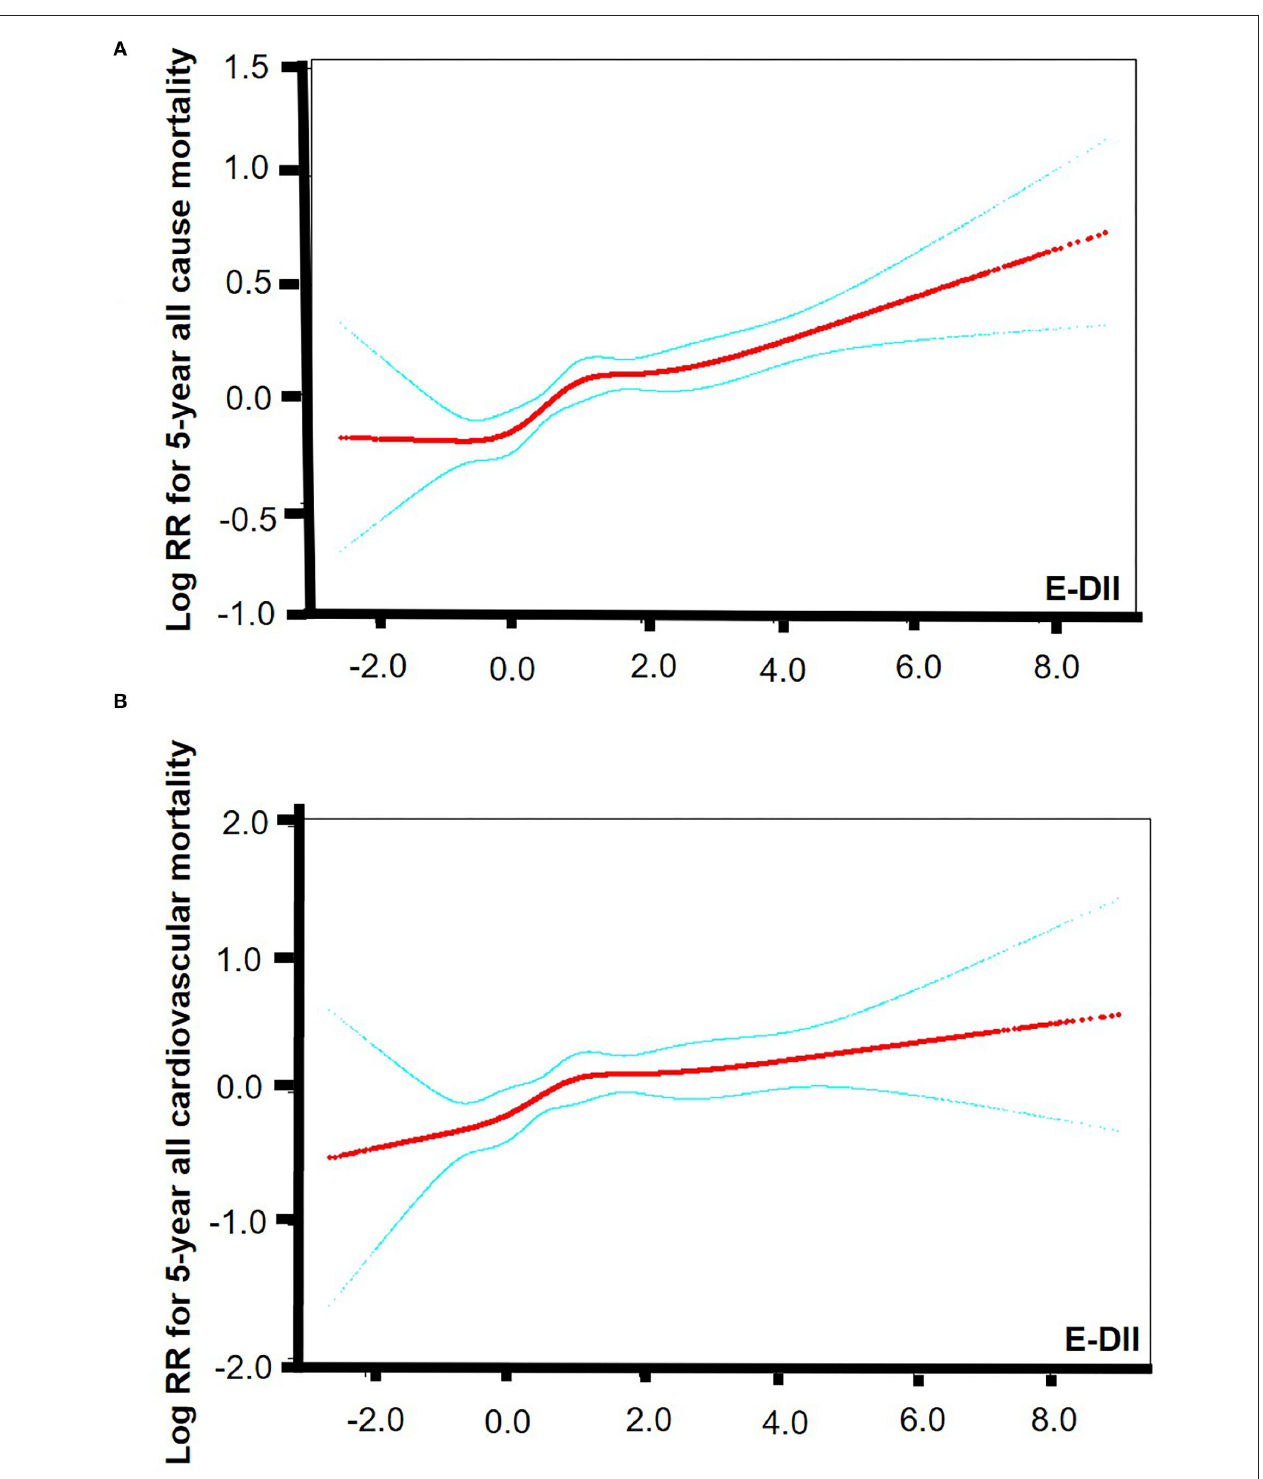
FIGURE 2 | Smooth curve fitting results. (A) Smooth curve fitting results between E-DII and 5-year all-cause mortality. (B) Smooth curve fitting results between E-DII and 5-year cardiovascular mortality. Risk of death (red) with 95% CIs (blue) determined using the Cox proportional Hazard Model. The p value for linear is < 0.0001. E-DII, Energy adjusted dietary inflammatory